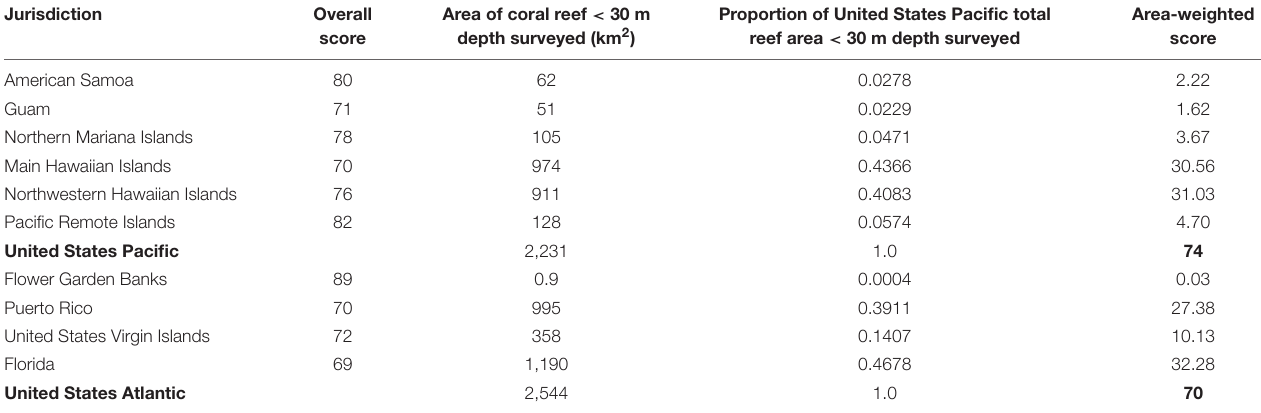
TABLE 10 | Calculation of overall Pacific and Atlantic basin scores based on area surveyed and proportion of total ocean basin area surveyed.